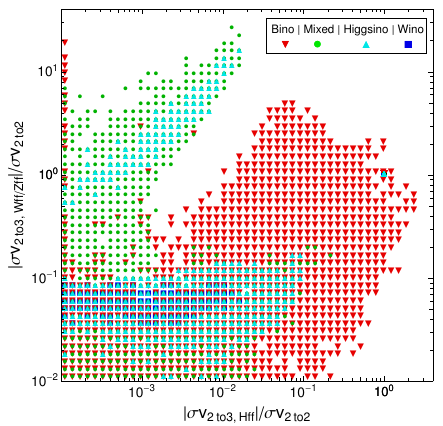
Figure 7 . Cross section for annihilation into three-body (cid:12)nal states containing a gauge boson versus that containing any of the Higgs bosons in the (cid:12)nal state, normalized to the total two-body cross section. Di(cid:11)erent neutralino compositions are indicated as in (cid:12)gure